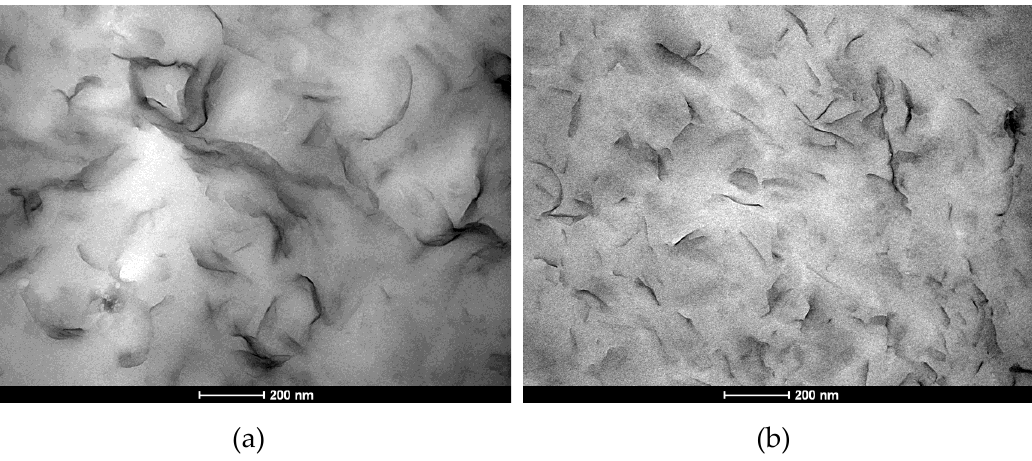
Figure 1: Transmission electron microscopy (TEM) image of coated samples produced at lab scale (6000× magnification) ( a ) without ultrasonication-treatment and ( b ) after 240 min of ultrasonication-treatment at 20 µm amplitude.